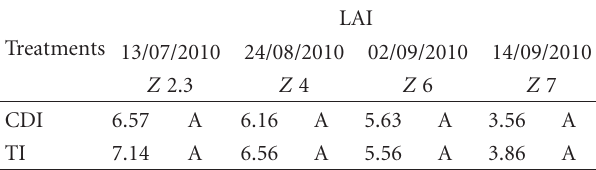
Table 11: Leaf area index (LAI) measured during di ff erent pheno- logical states under total irrigation (TI) and irrigation with con- trolled deficit (CDI) treatments.